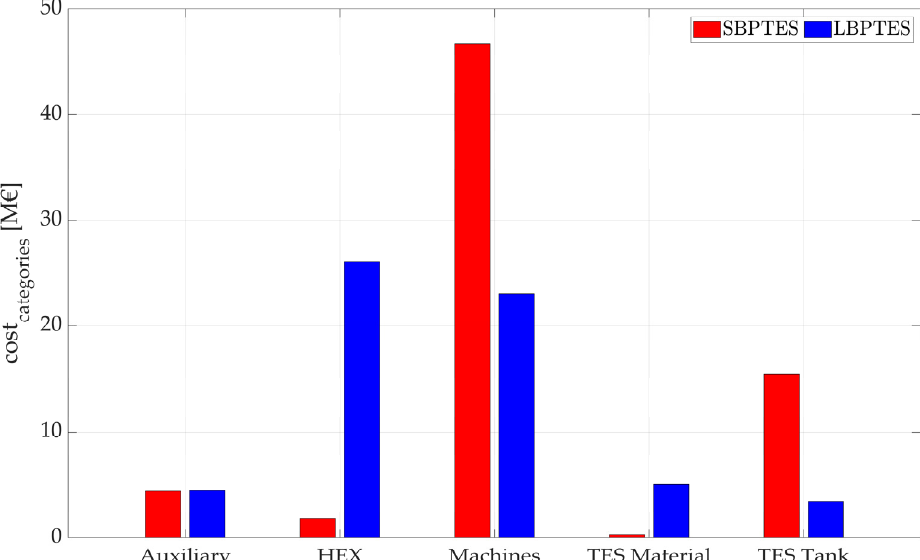
Figure 9. Cost categories for the LBPTES and SBPTES systems. Auxiliary comprises electric motors and generators; HEX accounts for heat exchangers and air coolers; Machines comprises turbines and compressors; TES materials represents hot and cold reservoir storage media; finally, TES tank comprises hot and cold reservoir containers. The results are related to a case with 𝑊(cid:4662) (cid:3041)(cid:3032)(cid:3047),(cid:3030)(cid:3035) = 50 MW, τ ch = 8 h and R ut = 0.8.